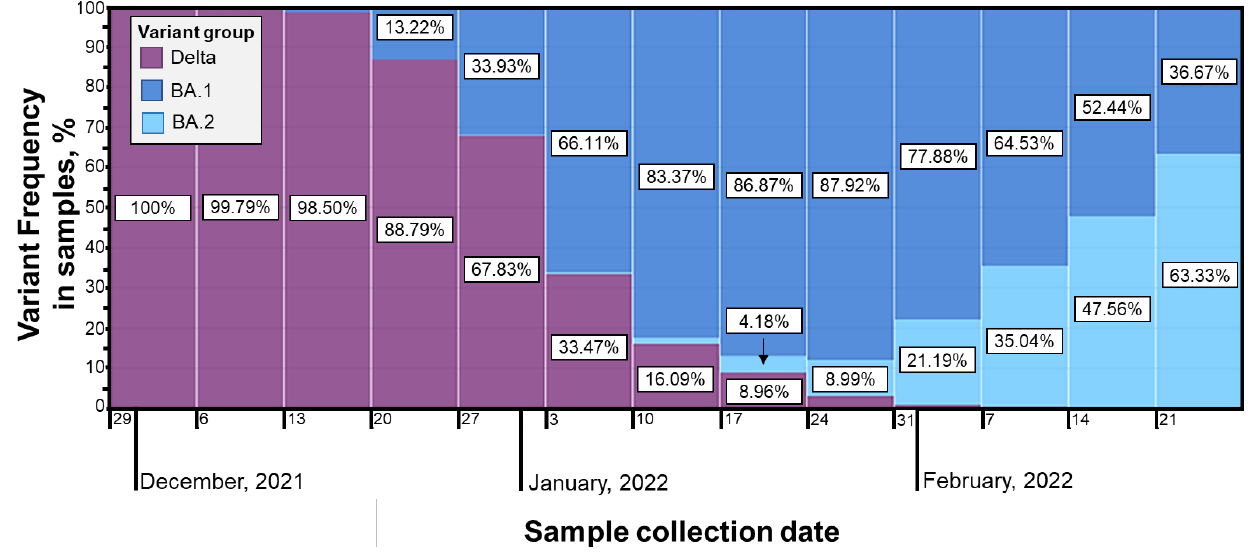
Figure A4. Delta and Omicron subtype changes in Lithuania. GISAID sequences from February 2020 to February 2022.